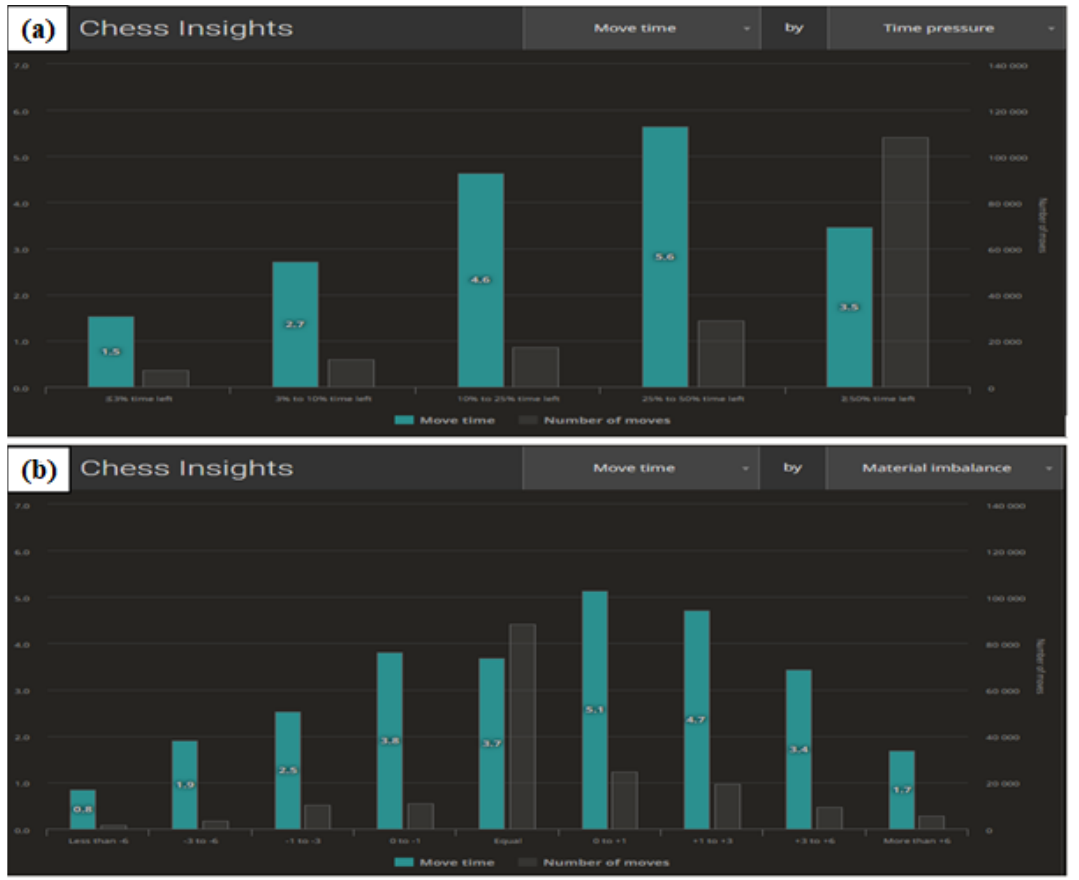
Figure 8. The effect of the pressure of elapsing time on the length of deliberation on a move ( a ) and the correlation of the average time spent on a move with the evaluation of the chess position ( b ). Source: lichess.org.